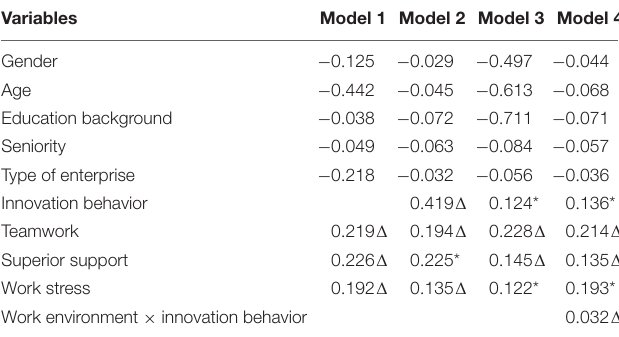
TABLE 7 | Hierarchical regression analysis.